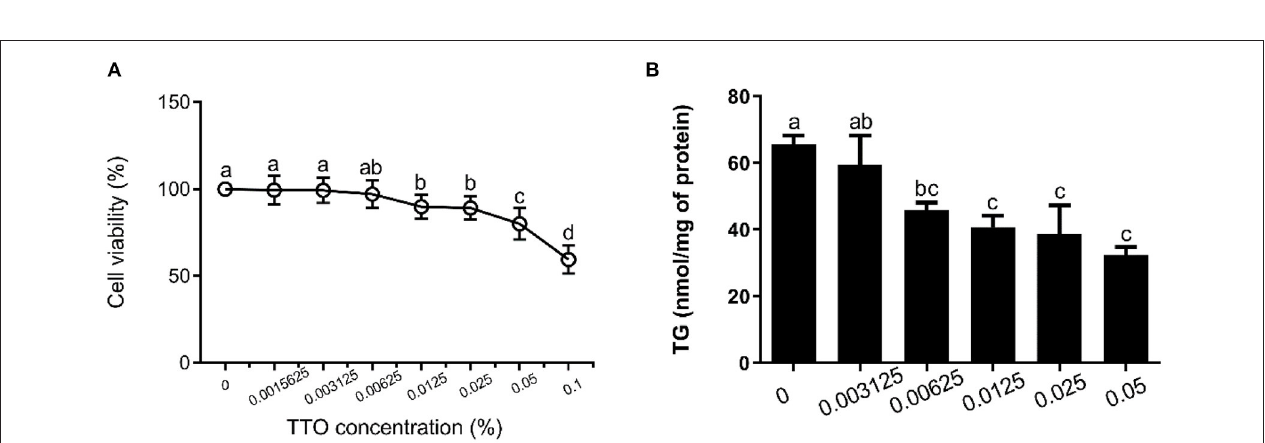
FIGURE 2 | Effect of tea tree oil (TTO) on cytotoxicity and triglyceride (TG) content in bovine hepatocytes. Cells were treated with various concentrations of TTO for 12h. (A) Cytotoxic effects of TTO. (B) The effect of TTO on TG content.